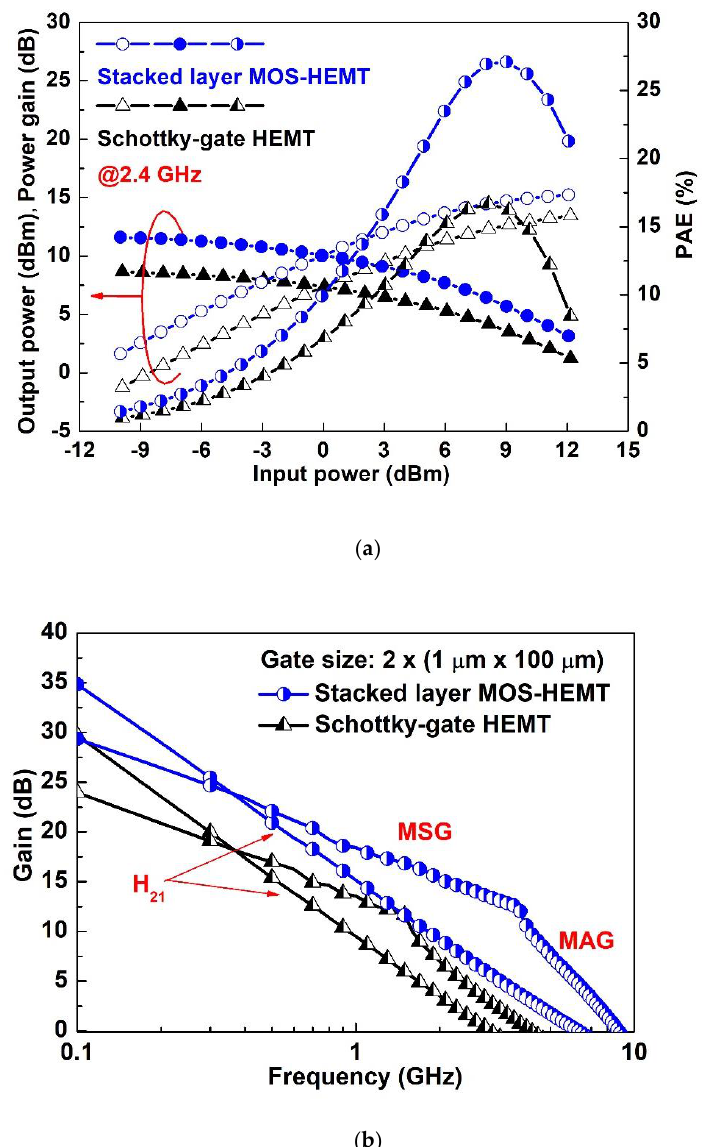
Figure 6. Comparison of ( a ) the microwave characteristics at maximum g m and ( b ) the power performance as a function of the input power at 2.4 GHz for both devices. Figure 7a,b show the temperature-dependent I DS -V DS degradation characteristics with various temperatures ranged from room temperature (i.e., 25 °C) to 100 °C for the